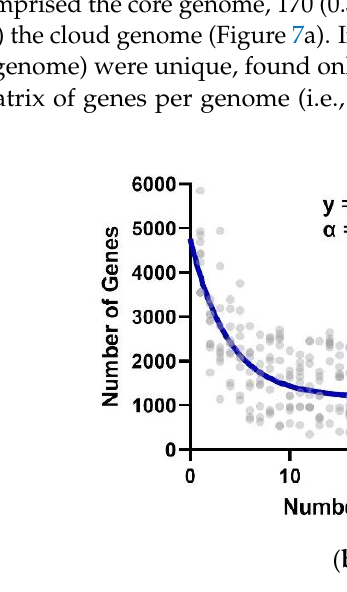
Figure 6. Estimation of the pan-genome for the genus Gordonia . ( a ) The number of total genes is plotted as a function of the number of genomes based on ten subsamples per genome. ( b ) The number of new genes is plotted as a function of the number of genomes based on ten subsamples per genome.